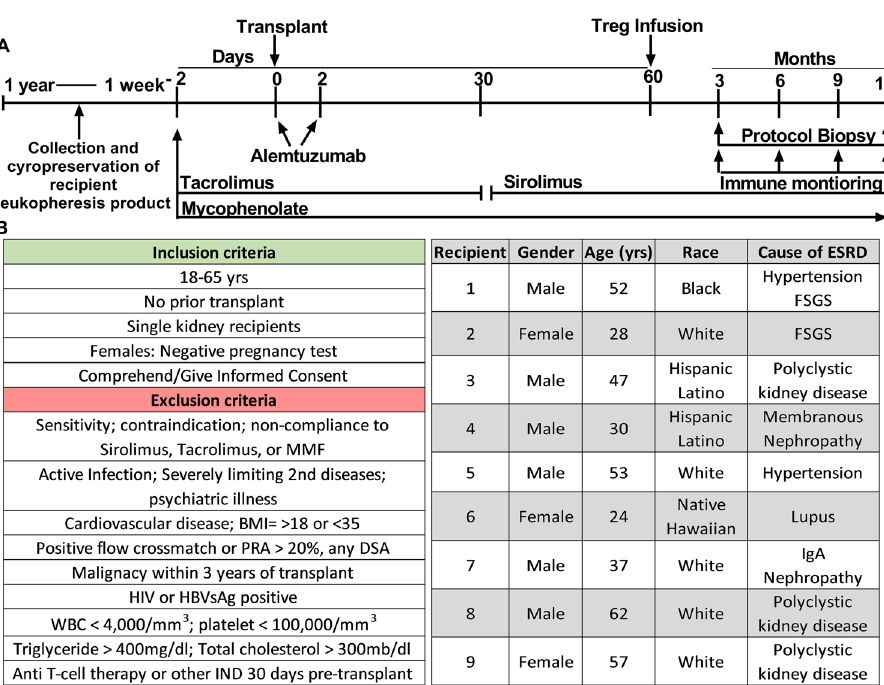
Figure 1. Clinical Protocol and subjects in the Phase I safety trial: ( A ) Outline of the clinical trial design from initiation to one-year follow-up. Although not listed patients were given intravenous corticosteroids of 500 mg pre-operatively, and weaned to 250 mg, 125 mg and 0 mg on post-operative days 1, 2 and 3 respectively. ( B ) The inclusion and exclusion criteria. The target population was adult recipients of living donor renal allografts that would not require hemodialysis during the first week following renal transplantation. ( C ) Demographics of living donor kidney transplant recipients receiving expanded autologous Tregs. Number of Tregs received by